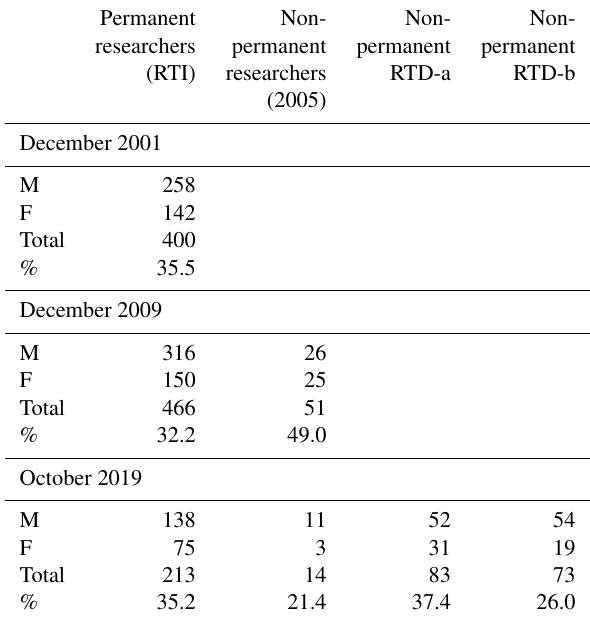
Table 8. Total number, male and female number and percentages of different types of permanent and non-permanent researchers posi- tions for the end of 2001, end of 2009 and October 2019 in the Ital- ian university system (data source: MIUR,